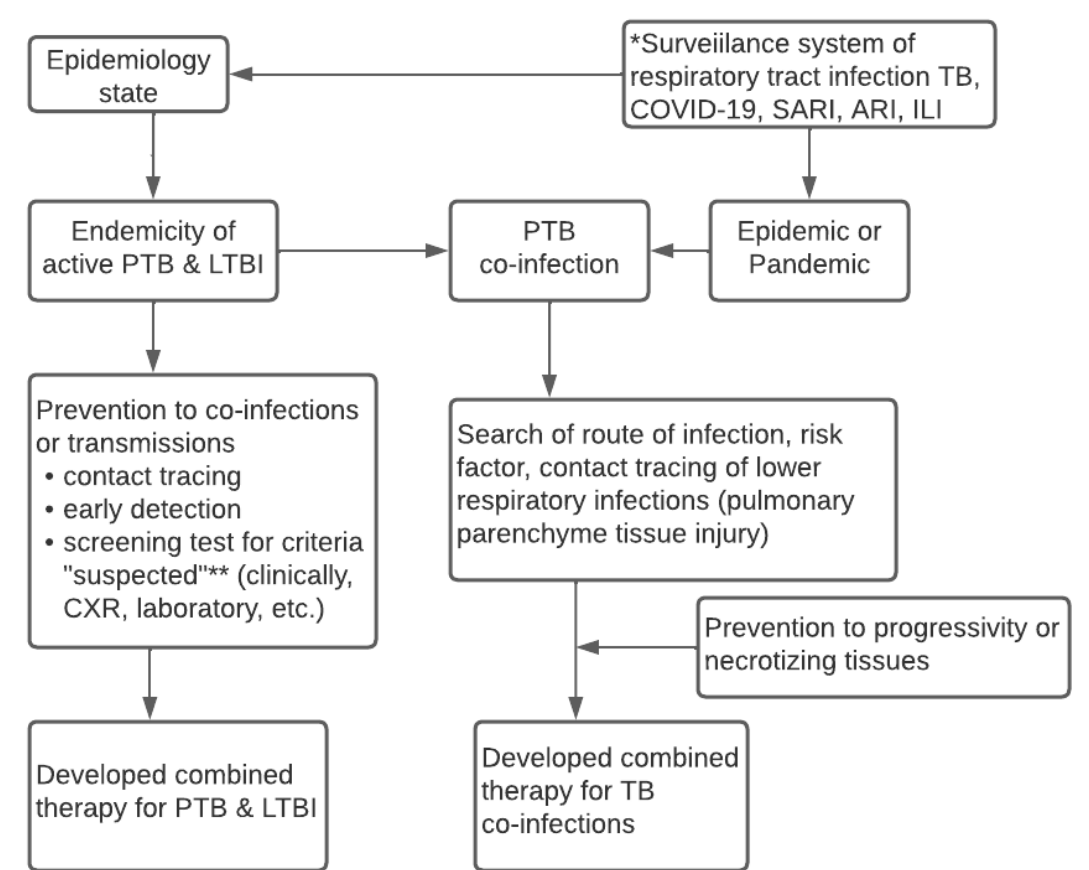
Figure 2. Conceptual Algorithm of TB—COVID-19 Integrated Management based on The Surveil- lance System. * Surveillance epidemiology system for respiratory infection related to WHO guideline 2020; ** Suspected criteria of COVID-19 based on WHO case definition 2020; ** Case definition of suspected TB based on WHO guideline 2010.